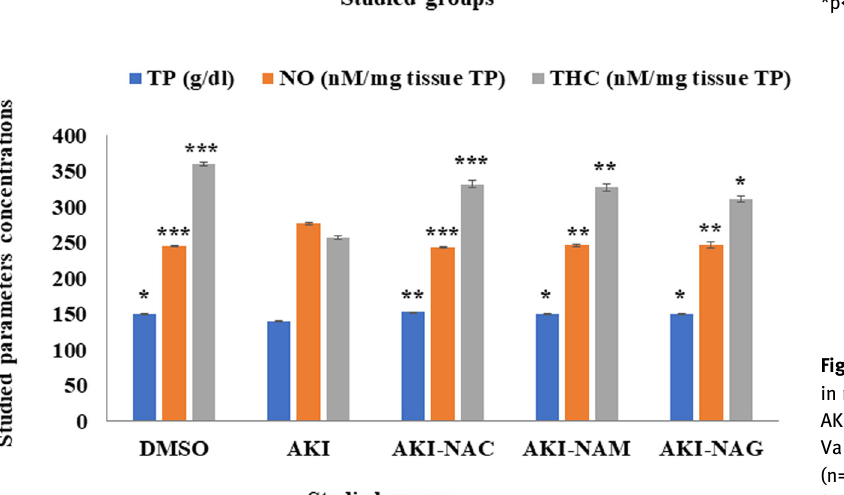
Figure 1: Serum urea and creatinine concentrations of DMSO, AKI, AKI-NAC, AKI-NAM and AKI-NAG groups. Values were expressed as mean ± SE (n=10).Signi fi cance:***p<0.001, **p<0.01, *p<0.05 comparing to AKI.